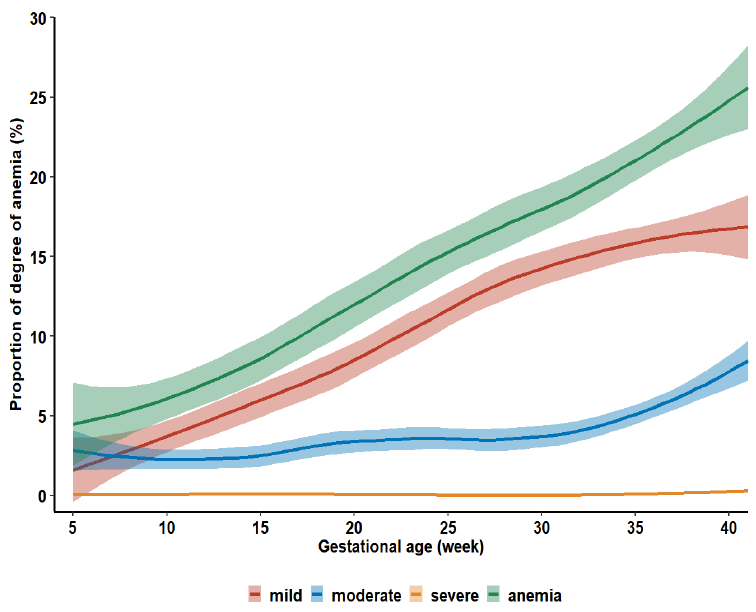
Figure 3. The estimated proportion of degree of anemia by gestational age. Restricted cubic spline was performed to reveal a non-linear variation of anemia during the gestational week.